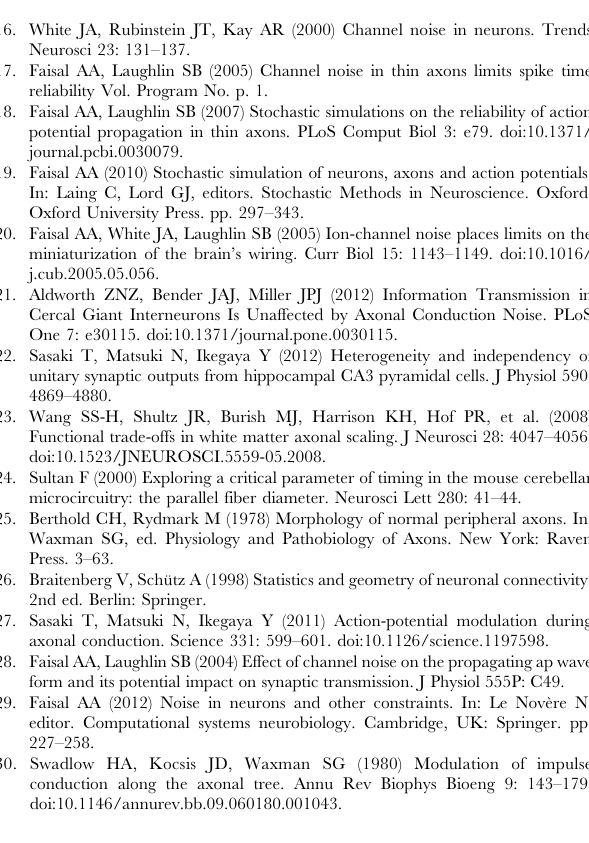
Figure S1 Correlation coefficient of waveform variability as a function of distance. Correlation coefficient of the difference between individual AP waveforms and the mean AP waveform recorded as a function of distance between record locations for 0.2, 0.5 and 1 micron diameter axons. (TIF) Figure S2 Peak of variability in waveforms of APs aligned at 20% of the AP peak. The peak of AP waveform variability is in the same position than in Figure 4, where APs were aligned at 50% of AP peak. This figure is produced in the same fashion as subpanels A and B from Figure 4, but AP waveforms have been aligned at 20% of the AP amplitude. (A) Typical shape of an action potential in the squid giant axon. (B) The variability in the waveform at each moment in time (N= 250). We define the variability as 3 6 SD of the membrane potential at each point in time. (TIF) Material S1 Modigliani configuration files for simulating the squid giant axon. All data required for other axons can be found in the methods sections, and related papers cited in that